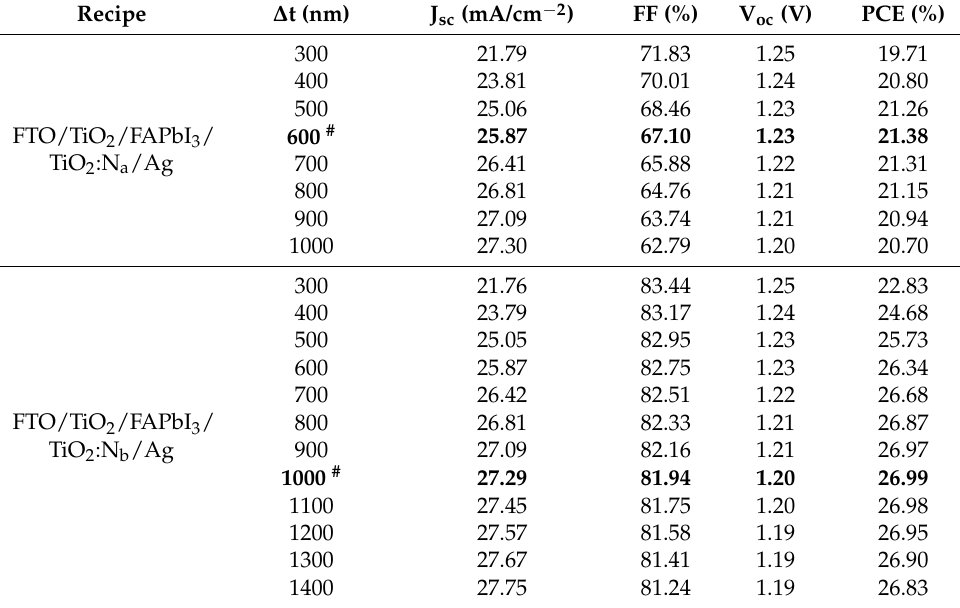
Figure 4. Spectrum of the maximum allowable absorber layer thickness for both recipes. Table 5. Performance parameters for both recipes with varied ∆ t.